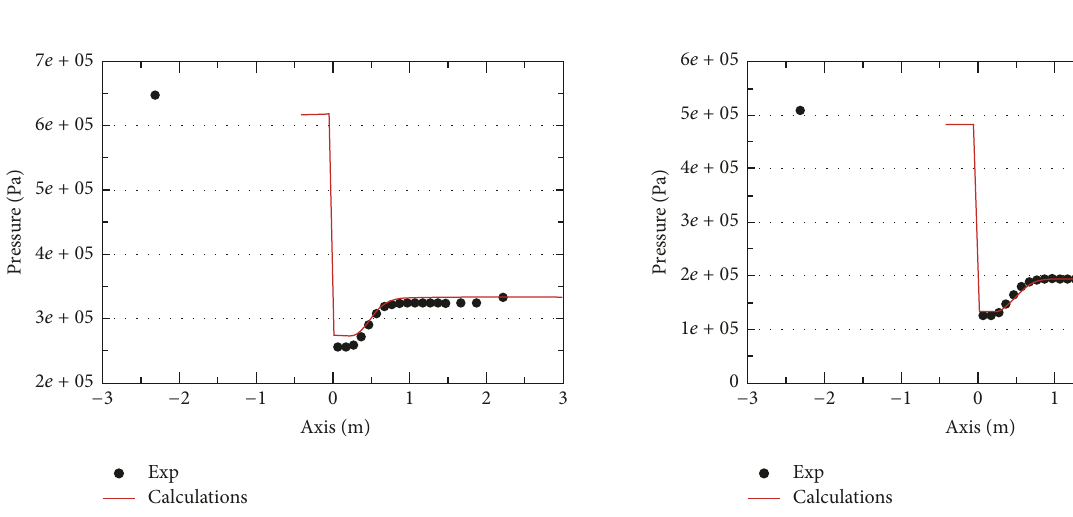
Figure 69: Lady 15 test.